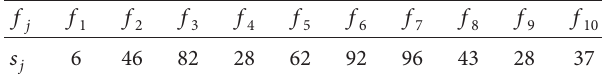
Table 3: Size files values for the case study.